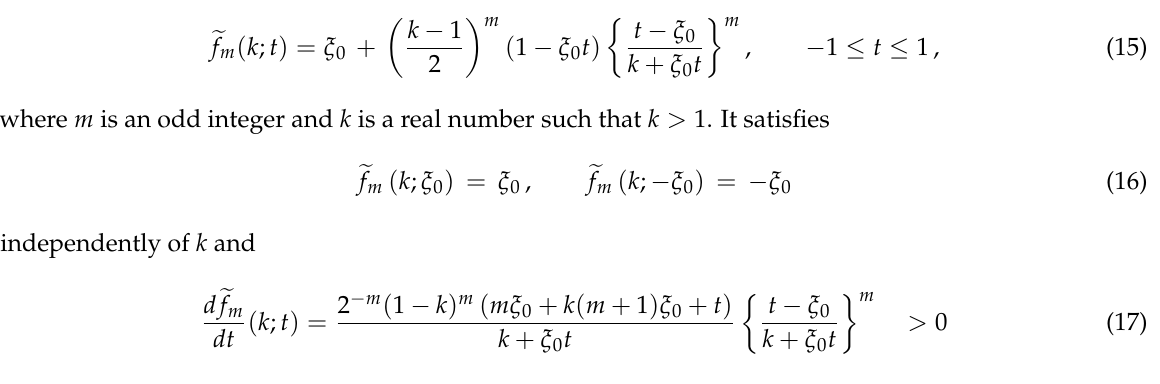
For an end-point singularity at ξ 0 with | ξ 0 | = 1 we suggest another rational transformation (cid:101) f m